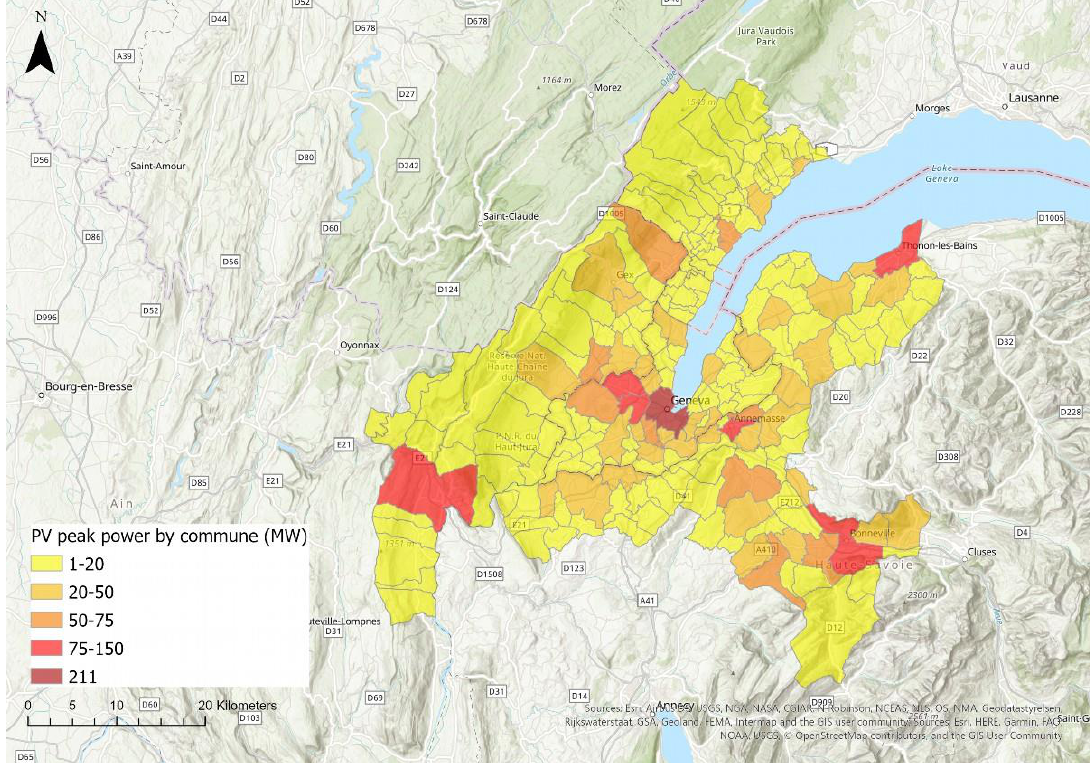
Figure 6. Potential total photovoltaic (PV) peak power by commune (i.e., municipality) of the Greater Geneva area.